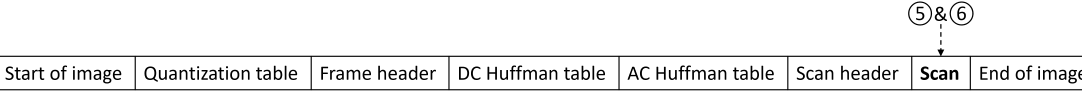
Figure 4. Simple syntax of JPEG compression. Each block is represented in hexadecimal values. Numbers 5 to 8 are locations where we extract datasets 5 to